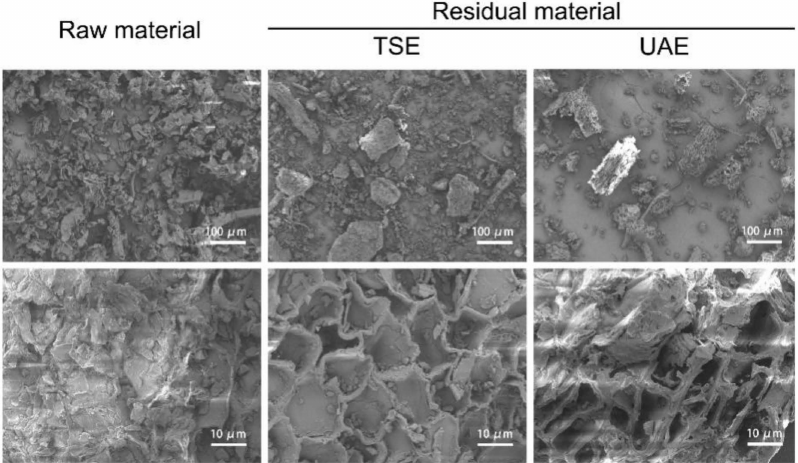
Figure 6. SEM images of J. mandshurica powder and its residues treated by UAE and TSE at magnifi- cation × 100 and ×